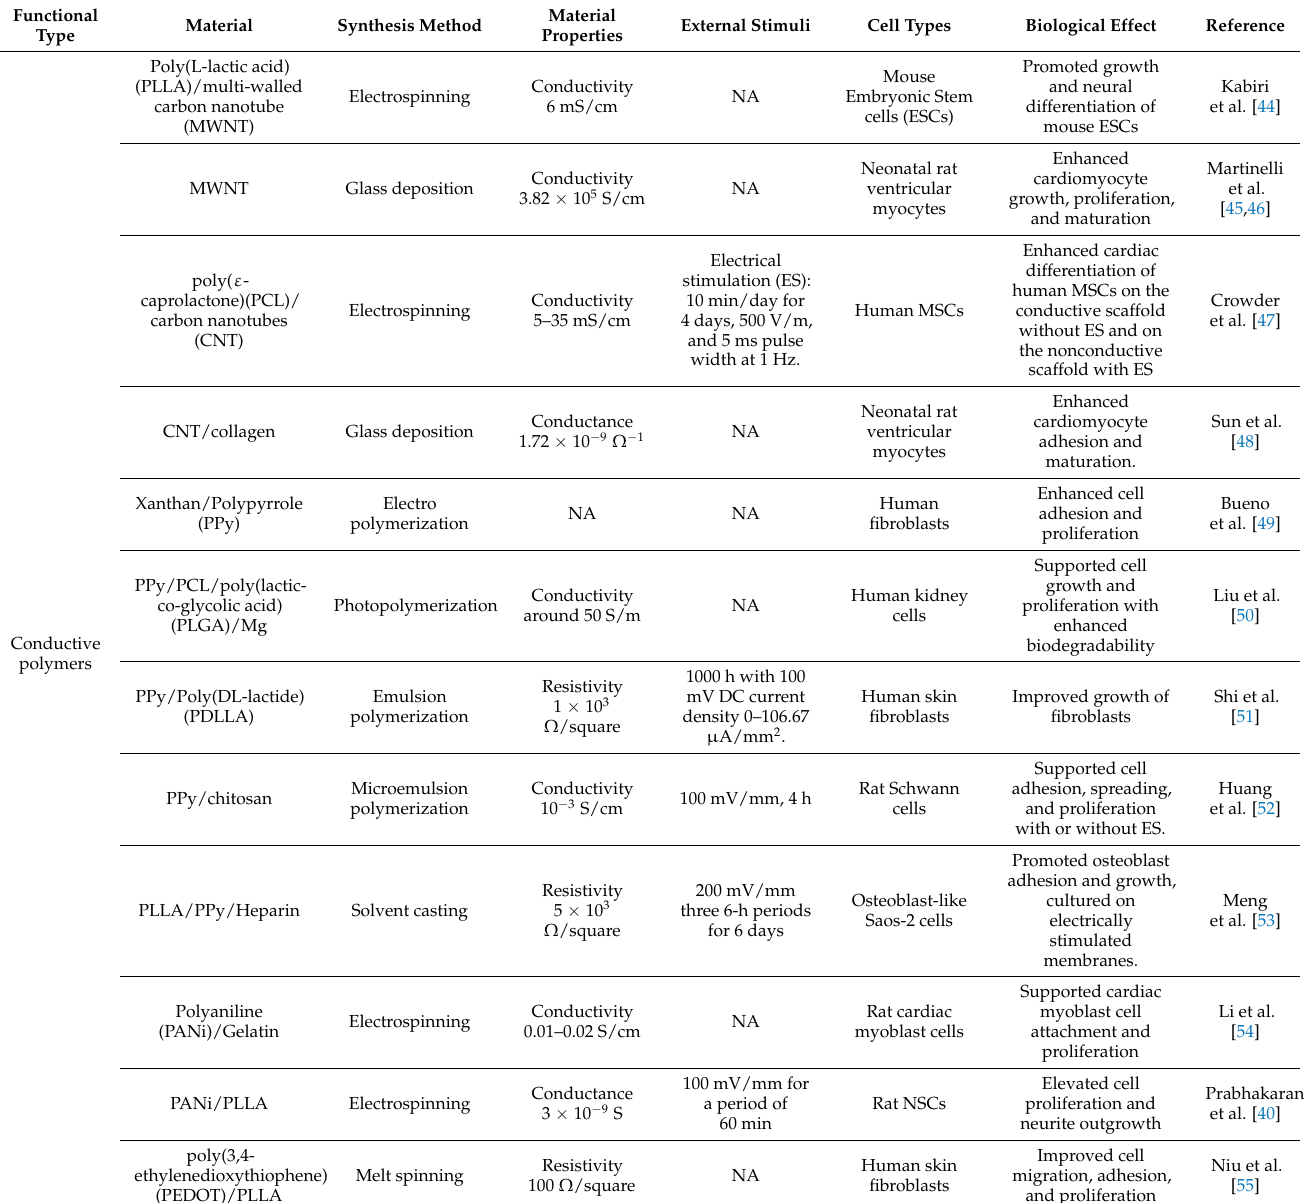
Table 1. Conductive polymers and their tissue engineering